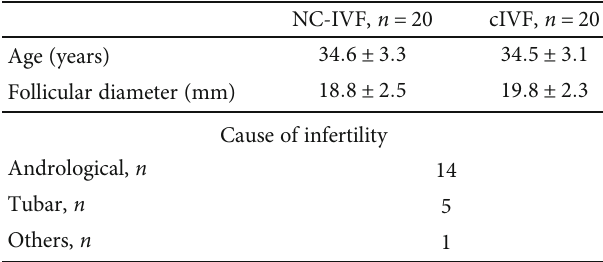
Table 1: Patient ’ s